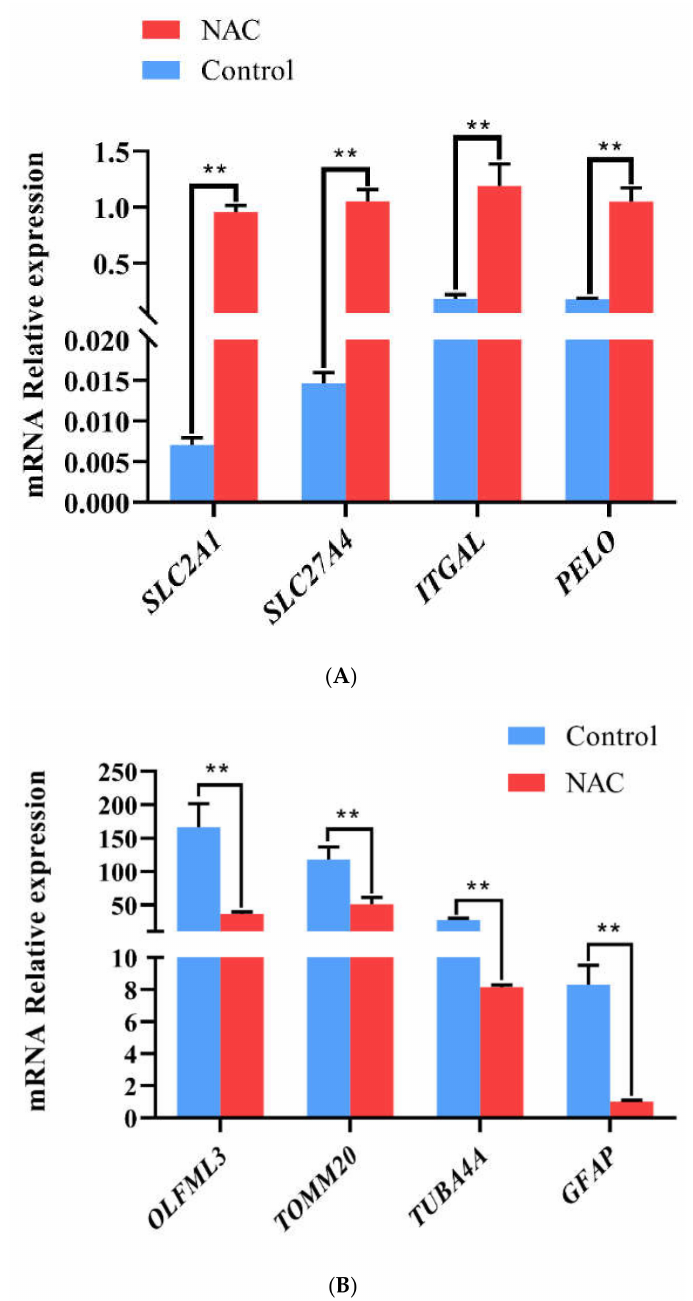
Figure 5. ( A ) Analysis of the transcript levels of upregulated differentially expressed proteins SLC2A1, solute carrier family 2 member 1; SLC27A4, solute carrier family 27 member 4; ITGAL, integrin, alpha L. ** indicates highly significant difference ( p < 0.01). ( B ) Analysis of the transcript levels of downregulated differentially expressed proteins. OLFML3 , olfactomedin-like 3; TOMM20 , translocase of the outer mitochondrial membrane member 20; TUBA4A, tubulin alpha-4A. ** indicates highly significant difference ( p <